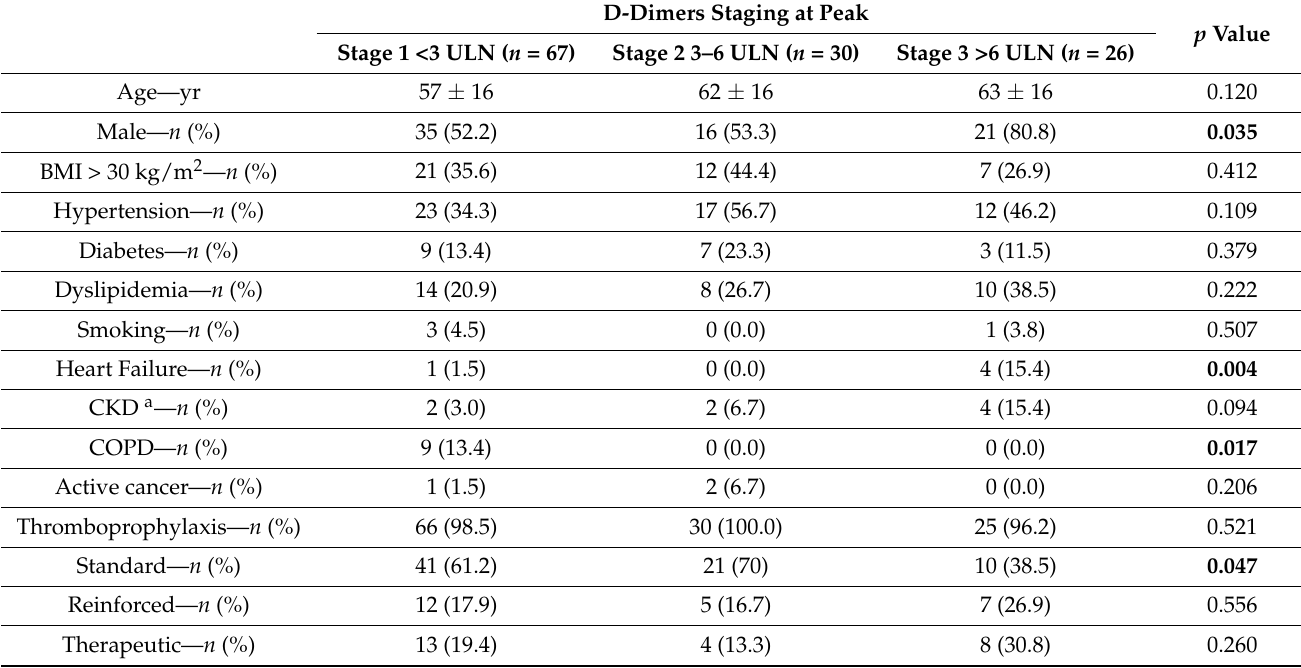
Table 1. Baseline clinical characteristics according to D-Dimers staging at peak.